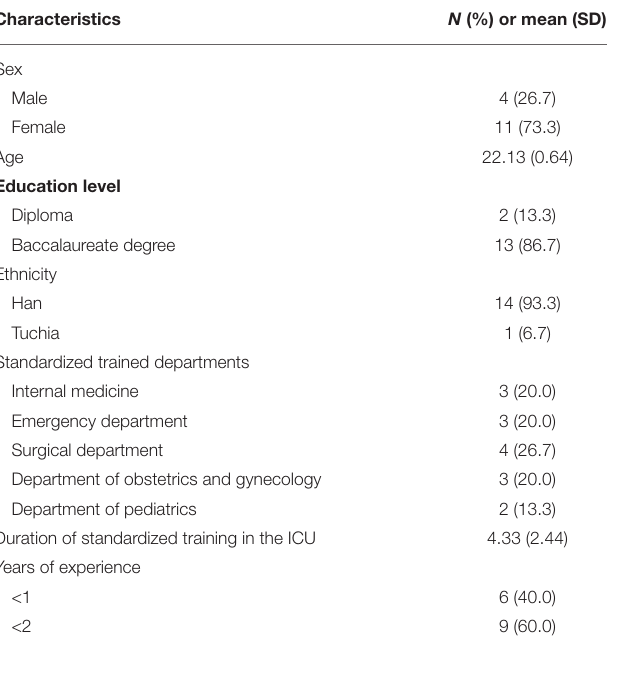
TABLE 2 | Characteristics of participants in this study ( n =